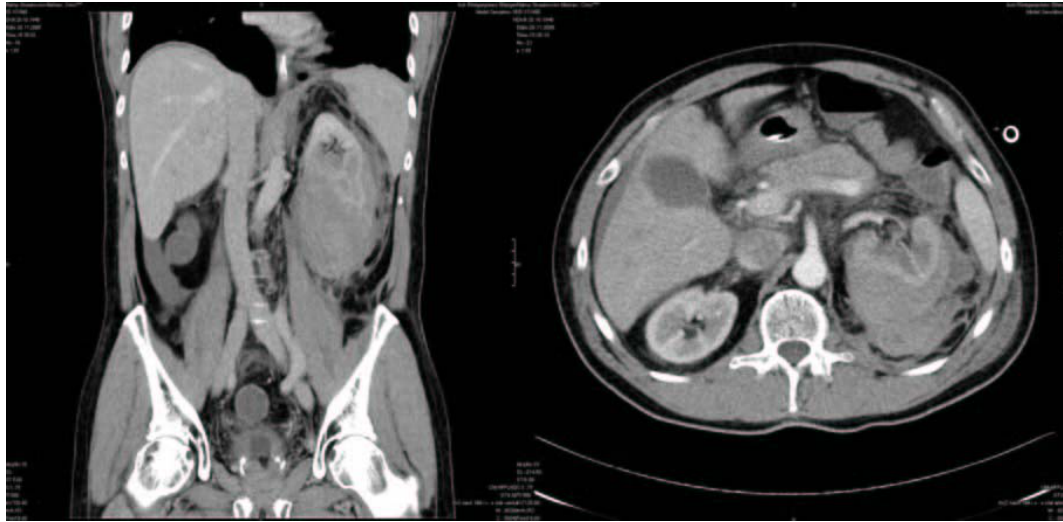
FIGURE 1 . CT of a left perirenal